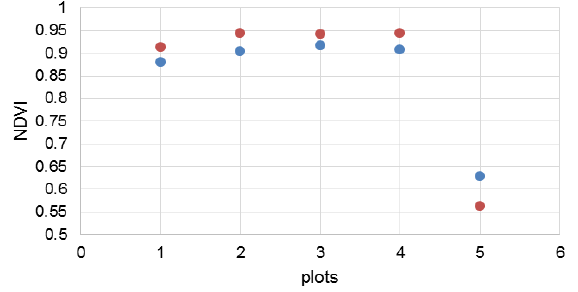
Figure 9. Average NDVI values per plot from MultiSPEC 4C measurements (blue) and field spectrometer measurements (red)